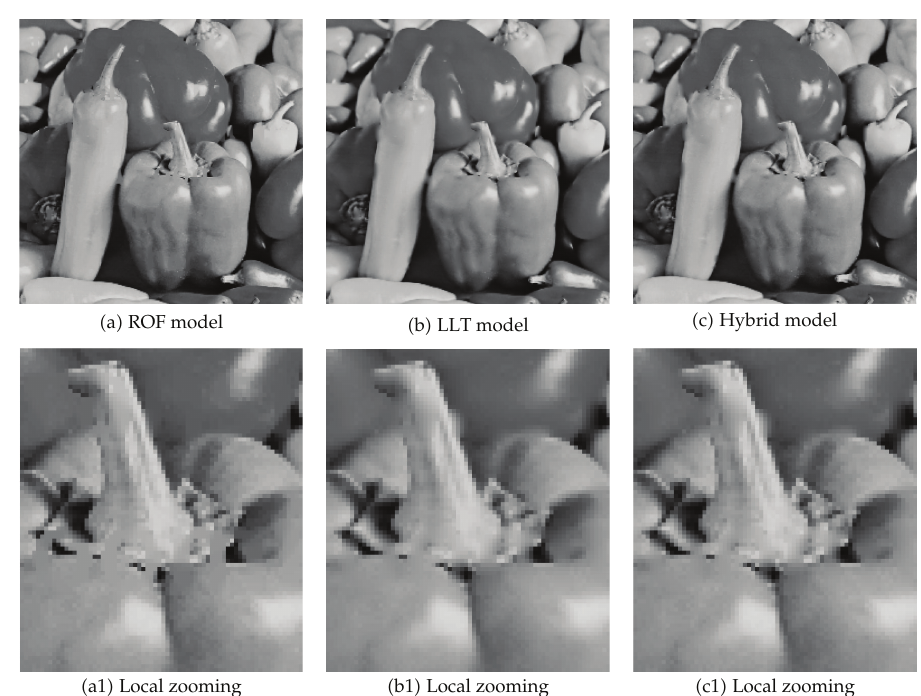
Figure 6: The related restored images corresponding to the painting image in Example